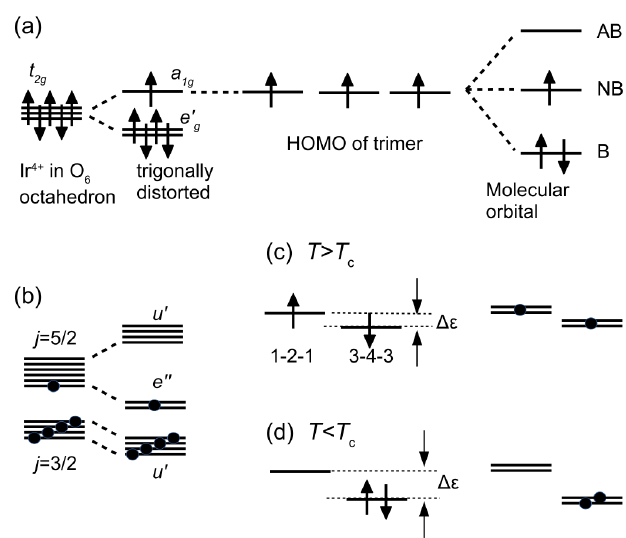
Figure 4. A model for the electronic states of BaIrO 3 starting from a localized electron picture. ( a ) the electronic configuration of Ir 4 + in a regular and trigonally distorted IrO 6 (left). The highest occupied orbitals of Ir 3 O 12 trimer (center) and the molecular orbital formation (right). B, NB and AB denote bonding, non-bonding and anti-bonding orbitals, respectively; ( b ) the electronic configuration of Ir 4 + in the strong spin-orbit coupling limit (taken from [33]); ( c ) the electronic states of BaIrO 3 above T c . 1–2–1 and 3–4–3 correspond to the inequivalent Ir 3 O 12 trimers; The case for strong